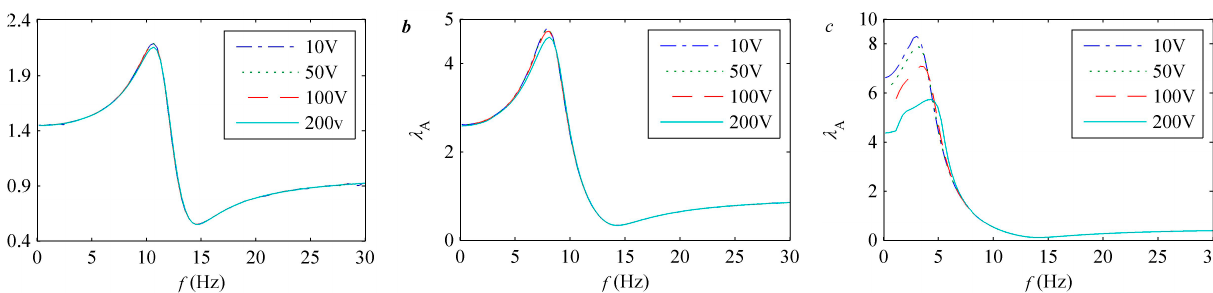
Figure 6. The simulation results for the ( a ) amplitudes and ( b ) amplified factors for a stiffness of 10 kN/m, applied voltage of 10 V, and pretension of 0.4, 0.8, and 1.2 mm over a range of frequencies.